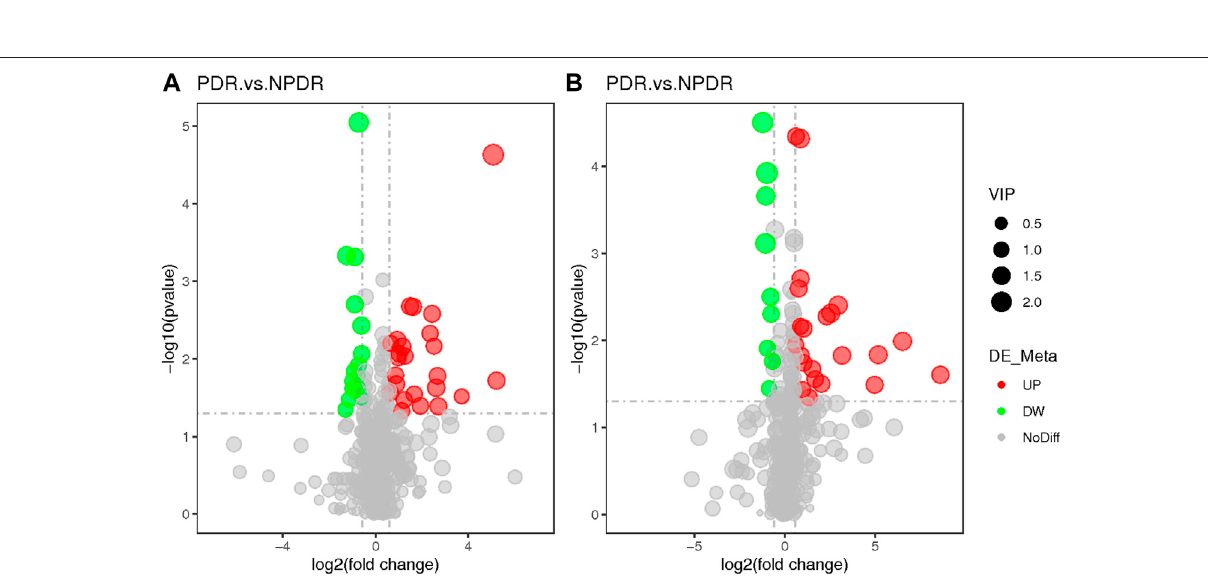
FIGURE 9 | (A) Positive mode. (B) Negative mode. Based on log2 (FC) and − log10 ( p -value) of metabolites, the volcano map showed that 122 features were signi fi cantly different between PDR patients ( n = 15) and T2DM patients ( n = 15). Metabolic features that were signi fi cantly higher (red dots) or lower (green dots) in PDR patients compared with NPDR patients were indicated, with dot size representing the VIP value. In the positive mode, compared with NPDR patients, 20 metabolic featuresweresigni fi cantlyincreasedand11metabolicfeaturesweresigni fi